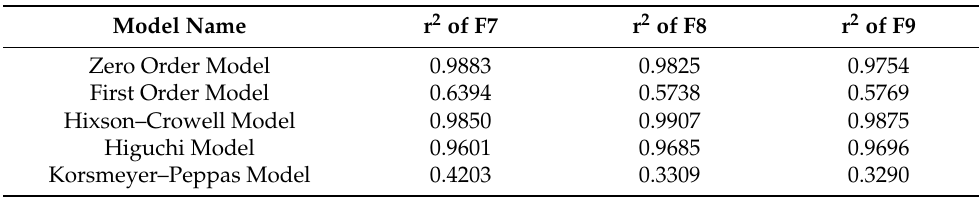
Figure 3. The percentage of SDF release from polymer matrices containing various drug to polymer ratios with the addition of MGS and STA over 12 h, using distilled water at 37 ◦ C, values are means ± S.D. ( n = 6). Table 1. Mechanism of SDF release from controlled release polymer matrices using various kinetic release models represented by r 2